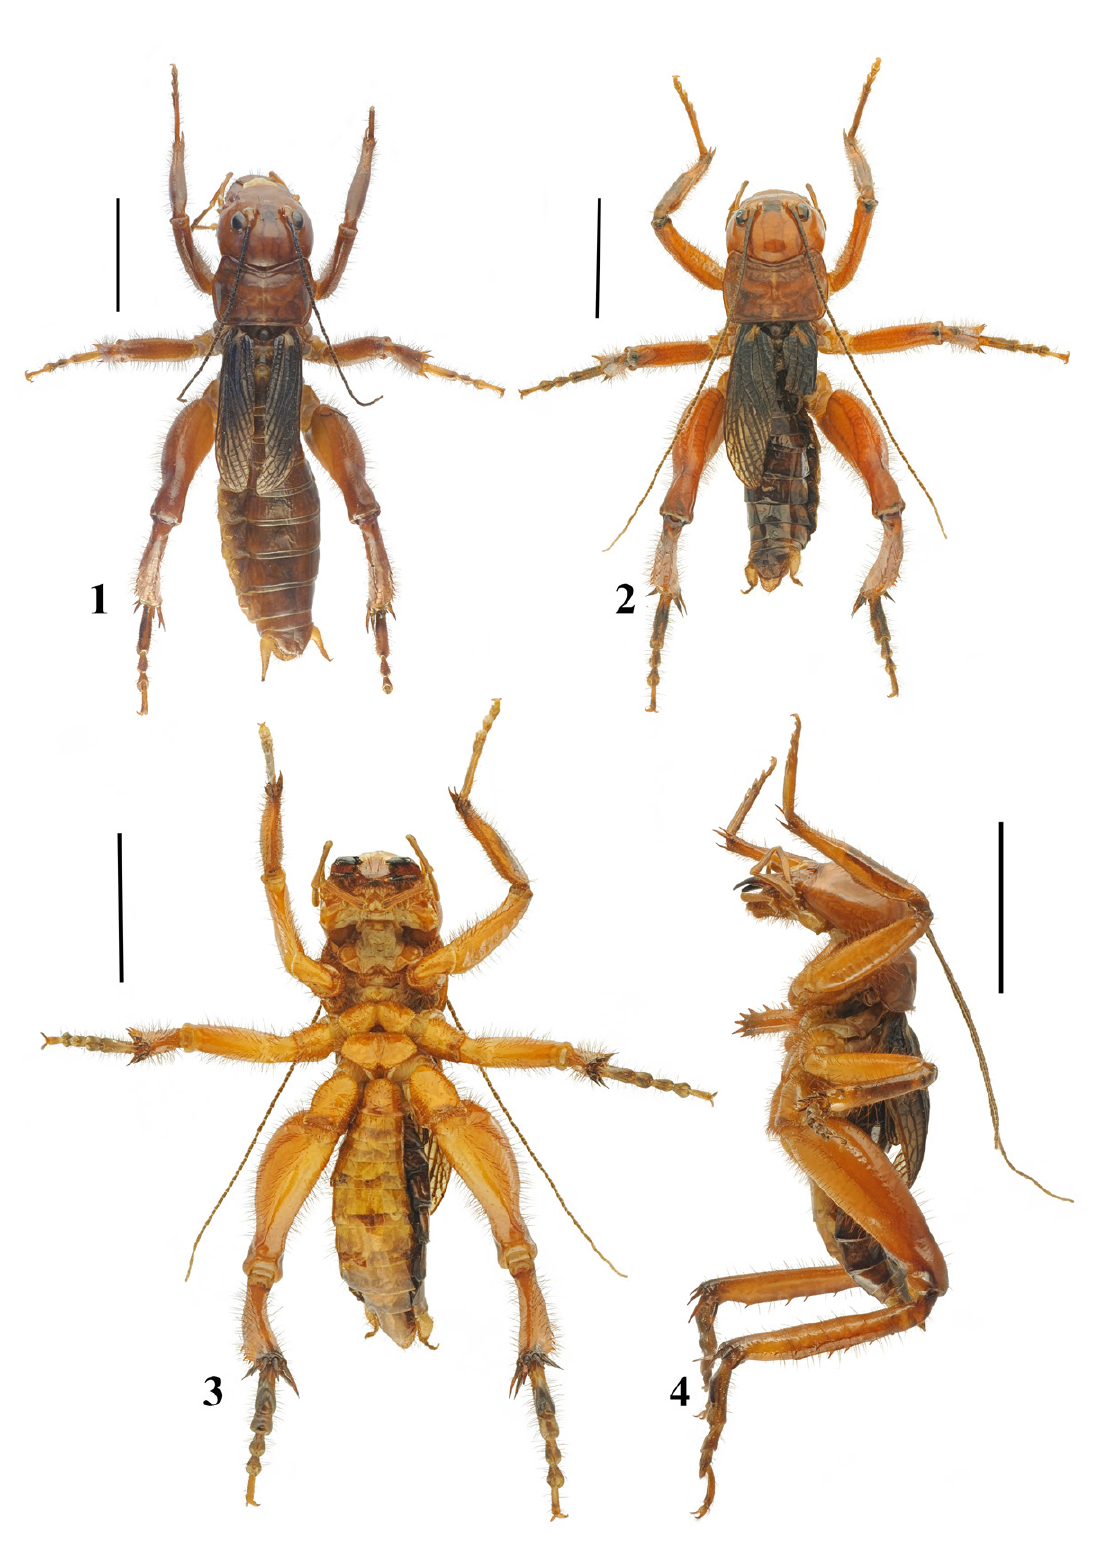
Figs 1–4. Oryctopterus varuna sp. nov., ♂. 1 . Holotype (NBAIR), dorsal habitus. 2–4 . Paratypes (NBAIR). 2 . Dorsal habitus. 3 . Ventral habitus. 4 . Lateral view. Scale bars = 10